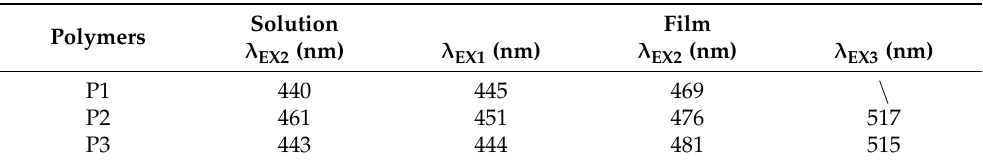
Table 1. The absorption peaks of P1, P2 and P3 solutions and thin films. The λ EX is the abbreviation of corresponding absorption peak.